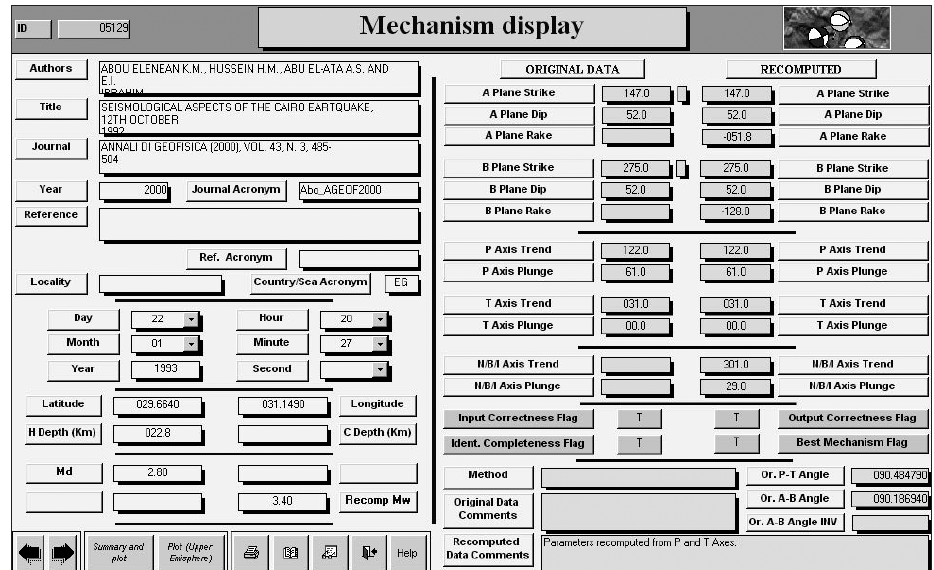
Fig. 3. Mechanism display